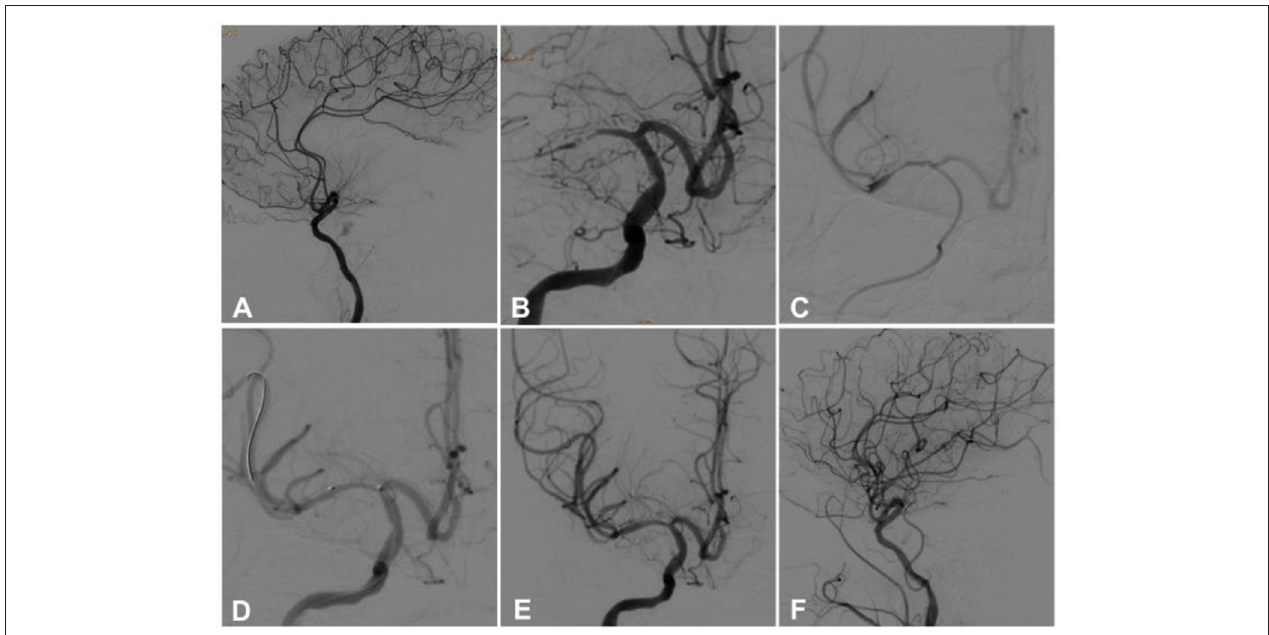
FIGURE 1 | A 36-year-old man had sudden onset of left limb weakness 17h ago, and the symptom was relieved after intravenous thrombolysis. However, the symptom was aggravated 4h later, and he was transferred to our hospital with the NIHSS score of 11. Magnetic resonance imaging demonstrated acute infarction in the right basal ganglia. (A,B) Before aspiration, cerebral angiography revealed occlusion of the right middle cerebral artery. (C) After the thrombus was removed by the aspiration catheter connected to the negative pressure pump, the blood flow forward was resumed. (D) During the procedure, a 2mm × 12mm balloon was used to expand the stenotic segment. (E,F) An Enterprise stent (4.5mm × 22mm) was deployed at the stenotic location, and the blood flow was restored to the modified Thrombolysis in Cerebral Infarction (mTICI) grade